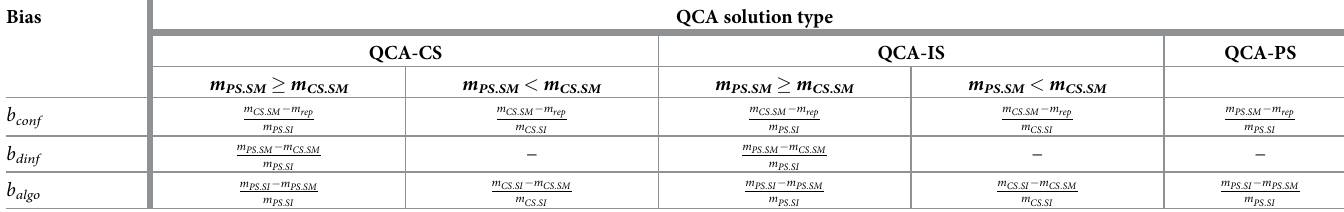
Table 6. Formulas for computing different types of bias in QCA.